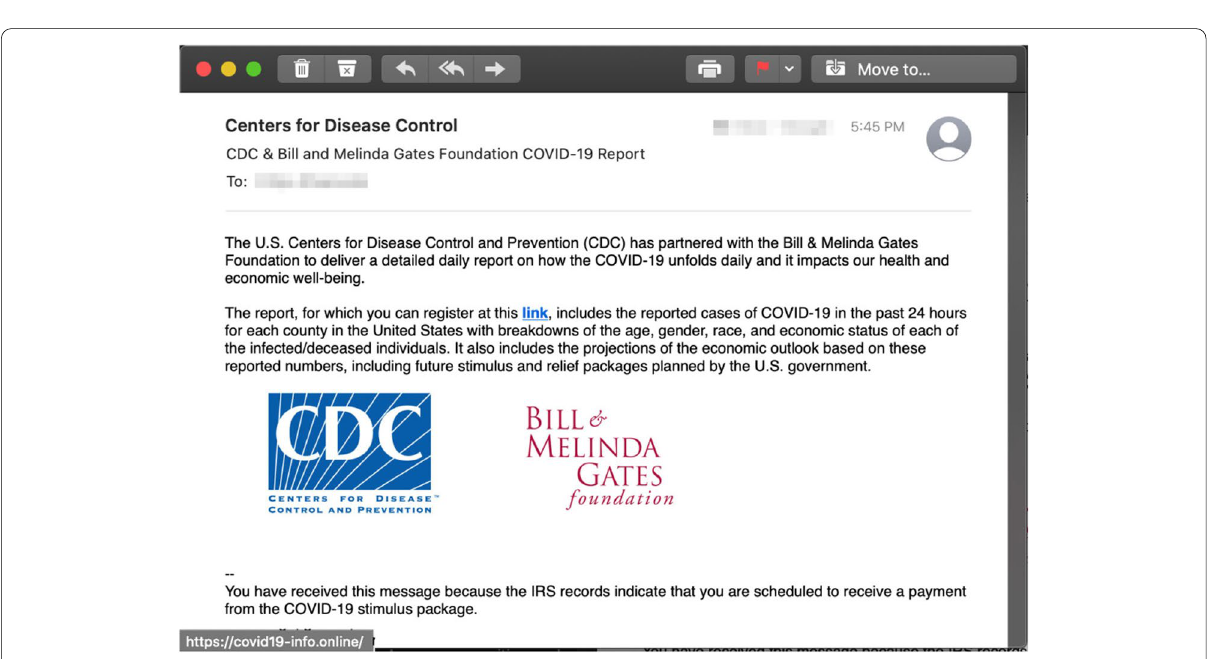
Fig. 6 Phishing email incorporating the scarcity and liking